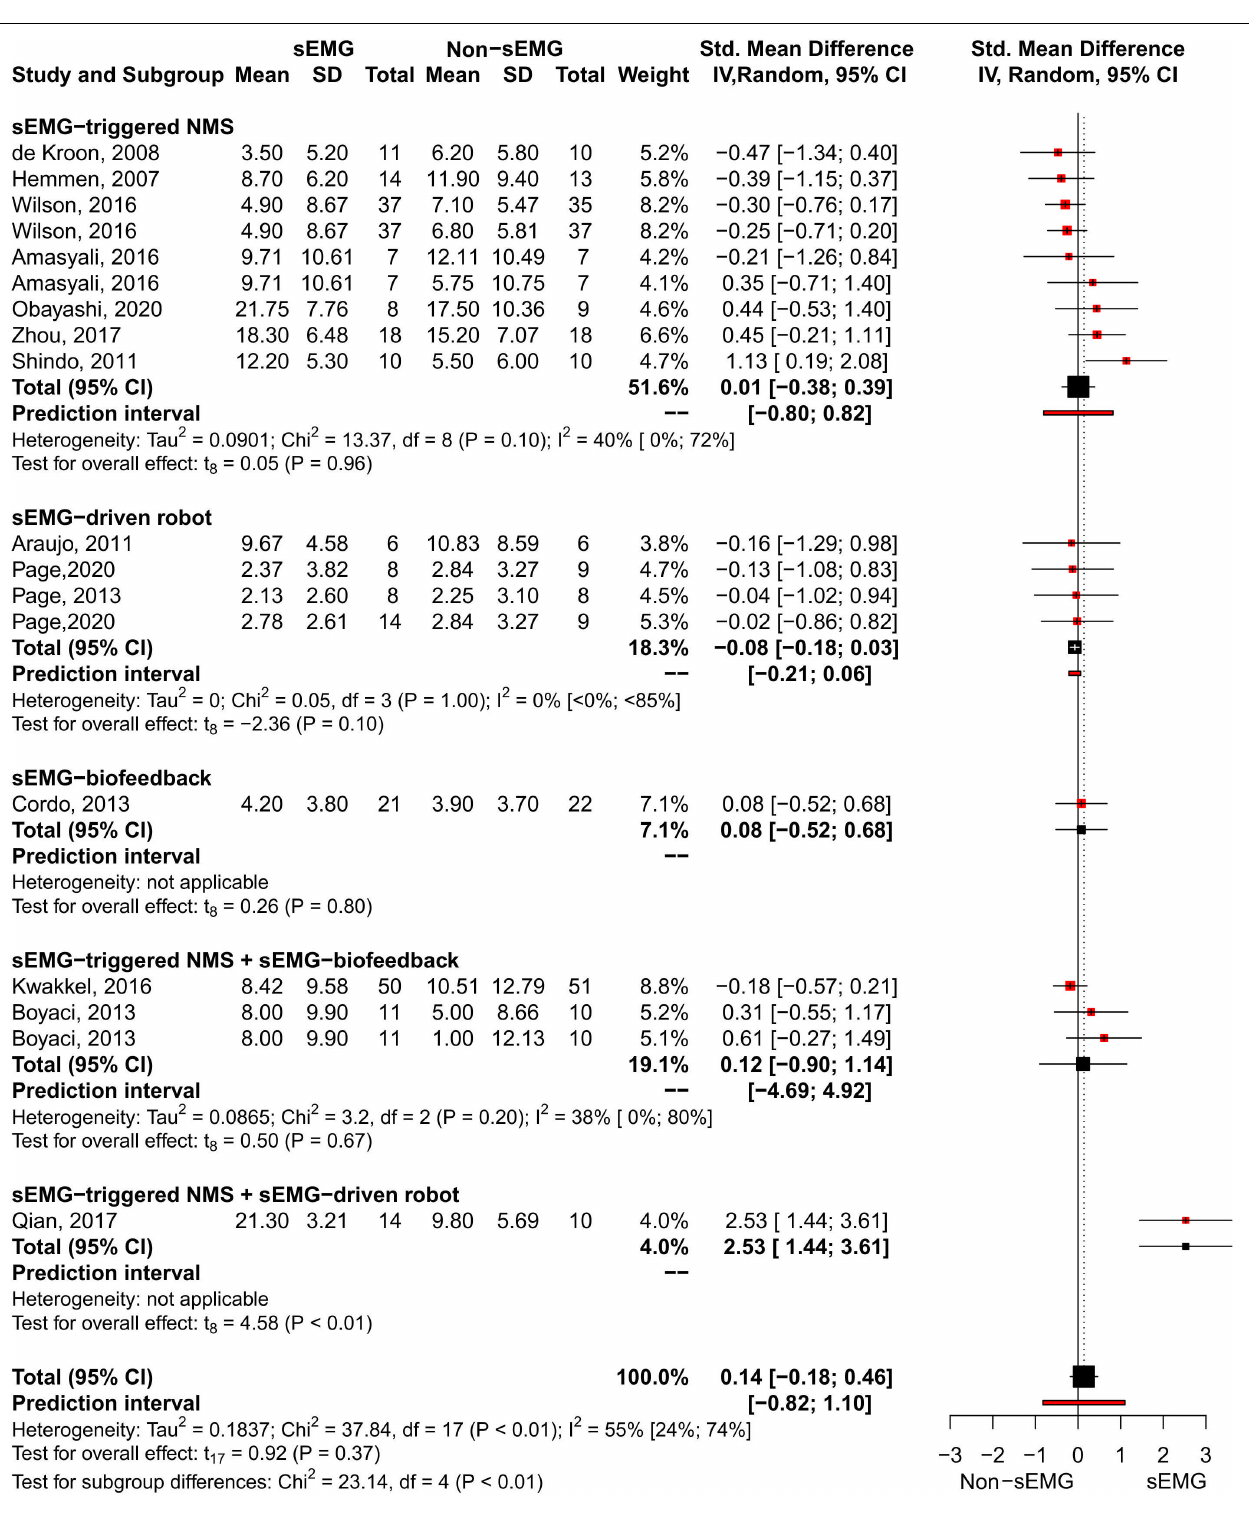
FIGURE 5 | Meta-analyses of the effect of sEMG intervention versus non-sEMG intervention on total FMA-UE score. s-EMG, surface electromyography; NMS, neuromuscular stimulation; +, combine with.